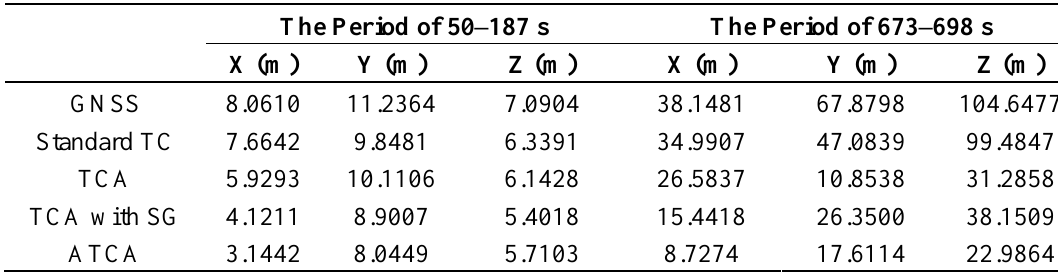
Table 4. RMS position errors.